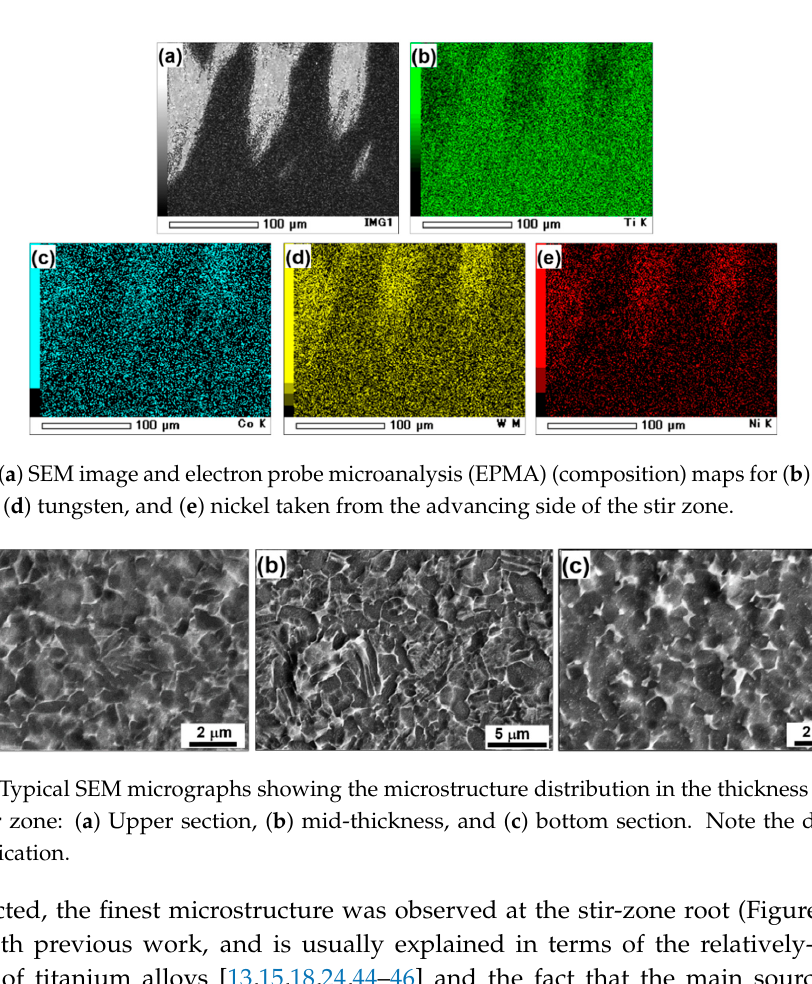
Figure 2. ( a ) SEM image and electron probe microanalysis (EPMA) (composition) maps for ( b ) titanium, ( c ) cobalt, ( d ) tungsten, and ( e ) nickel taken from the advancing side of the stir zone.